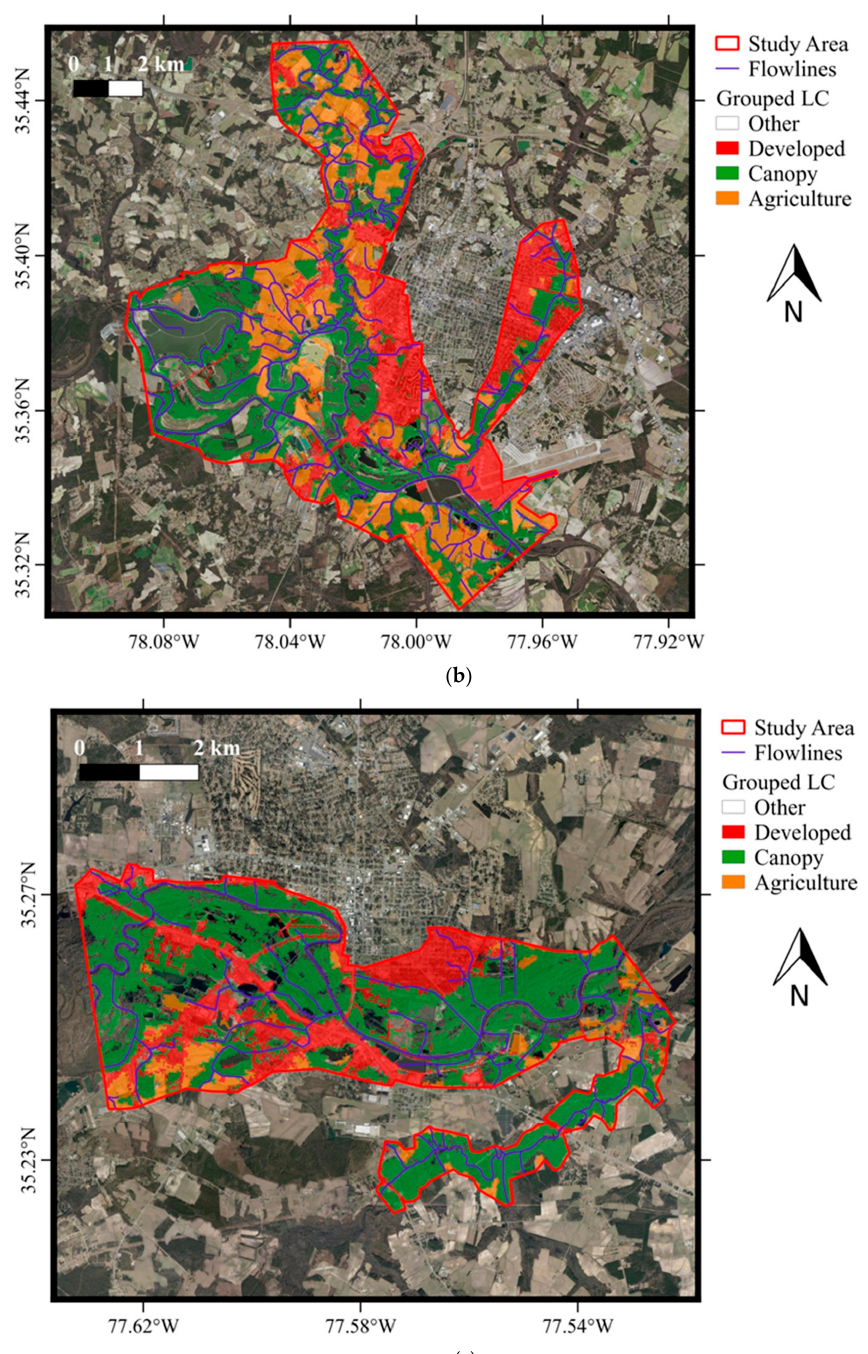
Figure 5. Illustrate the aggregation of the NLCD into one of three groups of interest including developed, canopy, and agriculture. All three study sites, Smithfield ( a ), Goldsboro ( b ), and Kinston ( c ), are shown.